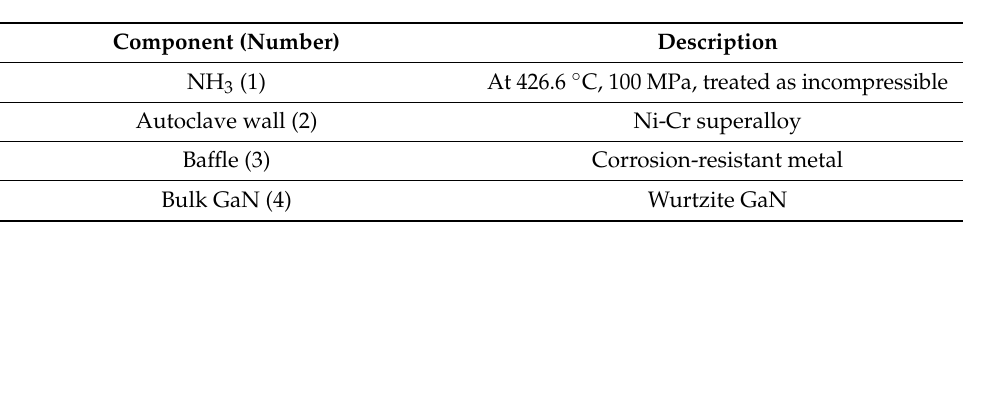
Table 3. Components with the numerical label used in Figure 1 and description of the